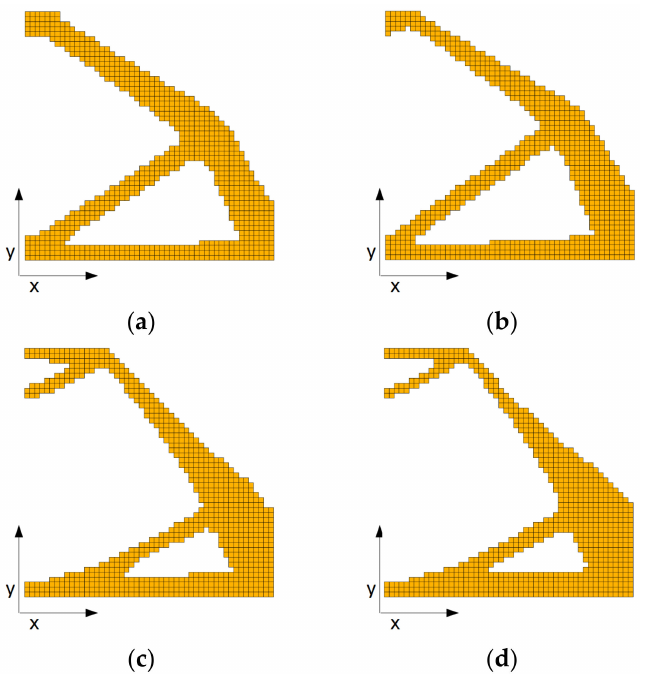
Figure 10. Final topologies obtained for square structure for the FGM-RAMP material interpolation scheme and x and y -directions of material gradation: ( a ) α = − 0.02, β = − 0.02, minimal compliance: 8.333 Nm; ( b ) α = − 0.04, β = − 0.04, minimal compliance: 32.581 Nm; ( c ) α = − 0.06, β = − 0.06, minimal compliance: 152.936 Nm; ( d ) α = − 0.08, β = − 0.08, minimal compliance: 819.221 Nm.